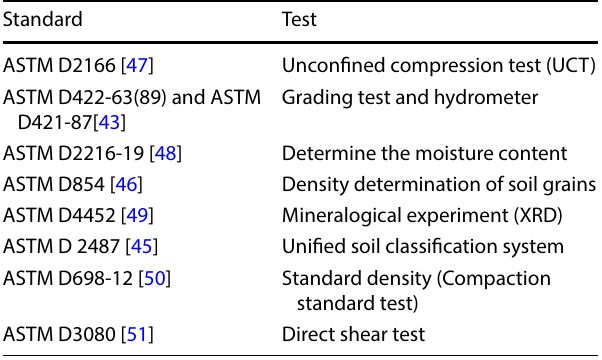
Table 6 Tests performed on the samples and their relevant stand- ards Standard